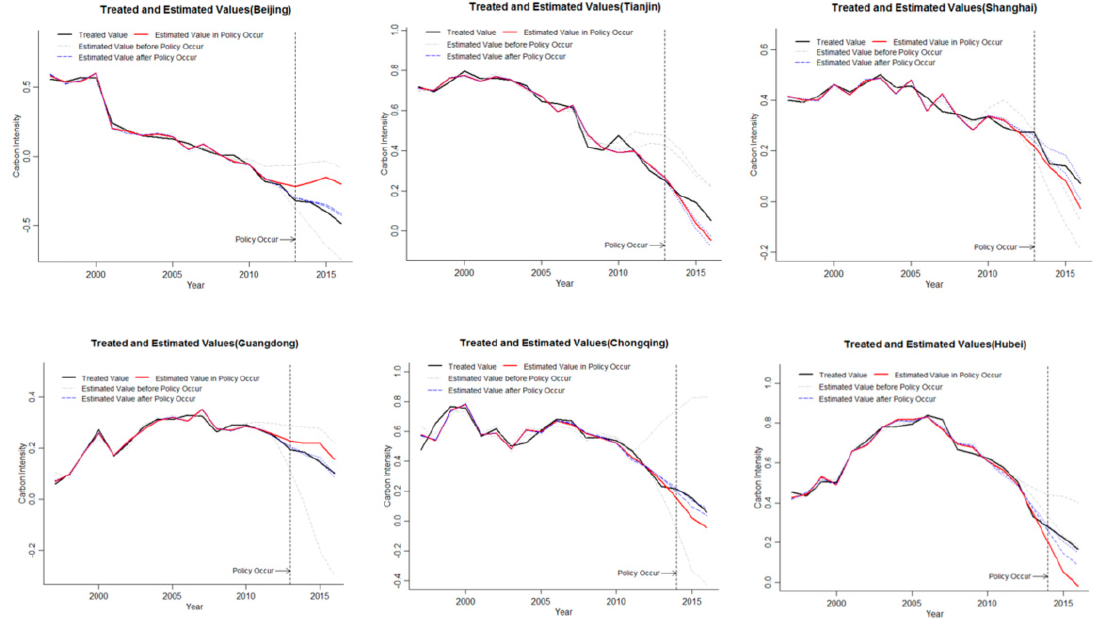
Figure 6. Carbon emission reduction effect robustness test.